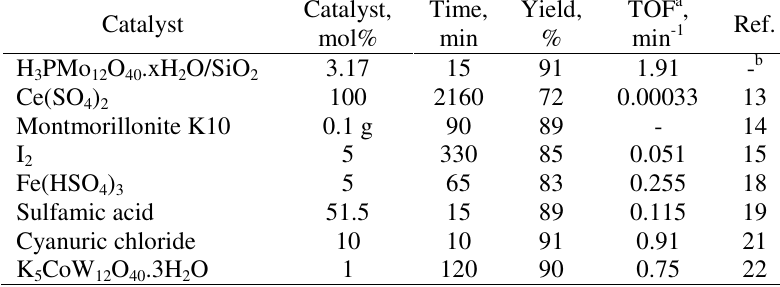
Table 3. Comparison of the results of the condensation of 2-naphthol with benzaldehyde and acetamide catalyzed by H reported